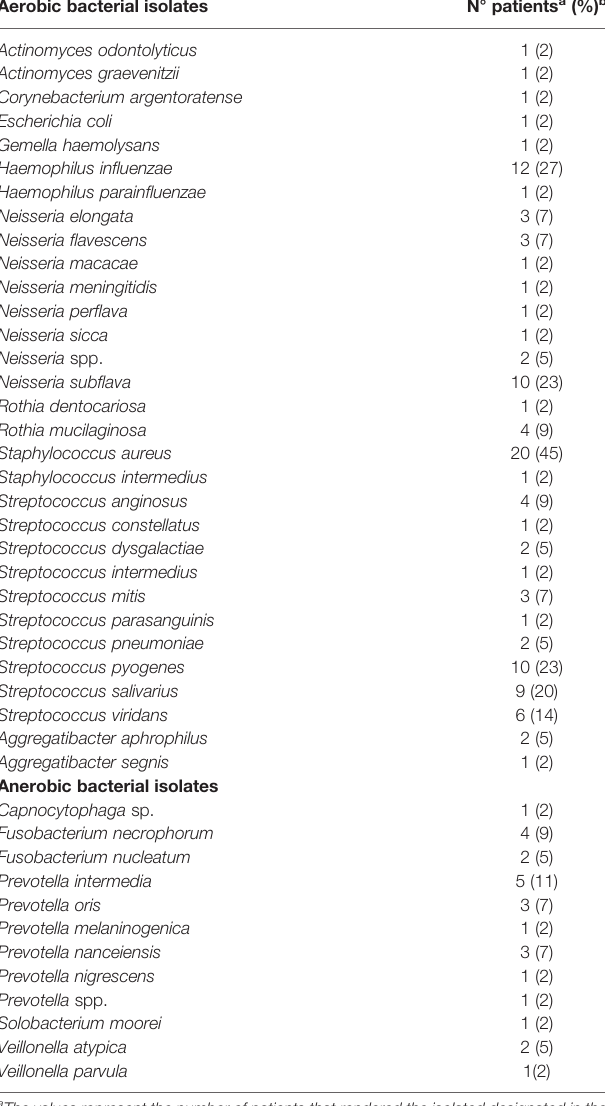
a The values represent the number of patients that rendered the isolated designated in the column of the left. b The percentages were calculated relative to the total number of patients